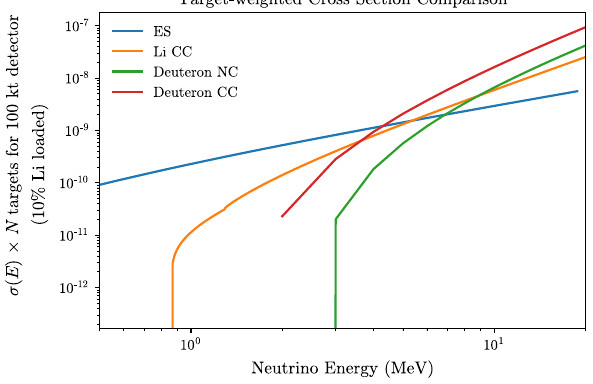
Fig. 10 Comparison of various interaction cross sections, weighted by the number of available targets for that interaction in a 100 kiloton detector. The elastic scattering (ES) and 7Li charged current (Li CC) interactionsareweightedfora100kilotondetectorof5%WbLS,loaded with 10% Lithium. The Li CC cross section is taken from [99]. The deuteron neutral current (Deuteron NC) and charged current (Deuteron CC) are weighted for a 100 kiloton detector entirely of heavy water, D